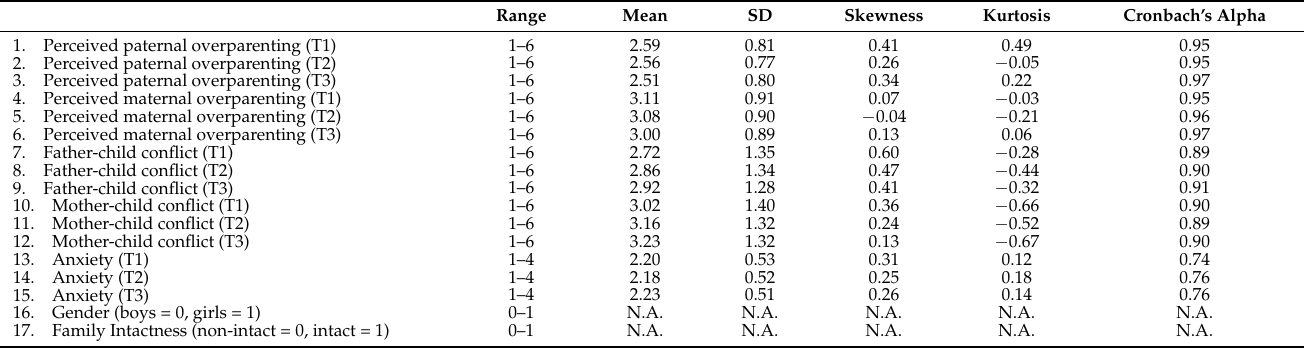
Table 1. Descriptive statistics of the variables.